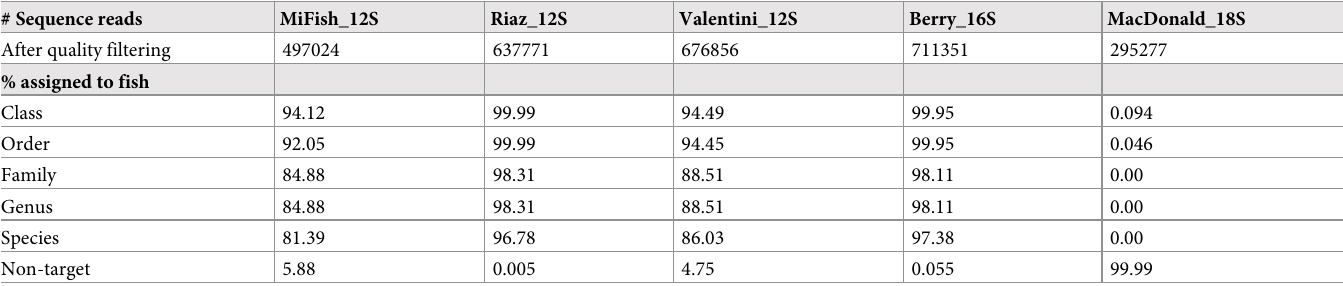
Table 2. Illumina sequencing